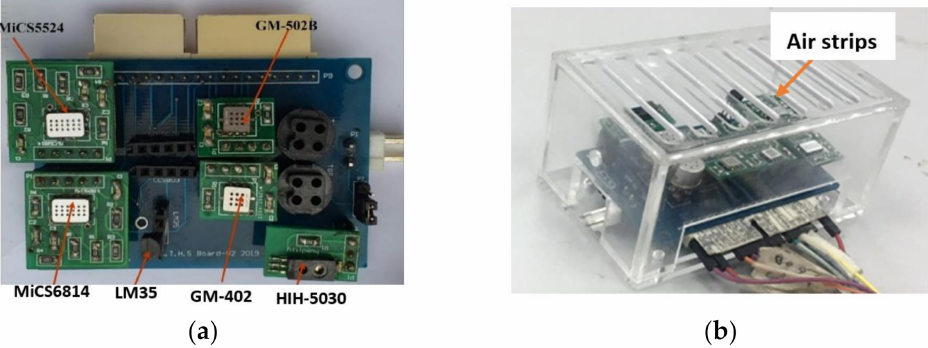
Figure 2. ( a ) Gas sensor modules developed; ( b ) fabricated partially closed chamber using acrylic with all gas sensor